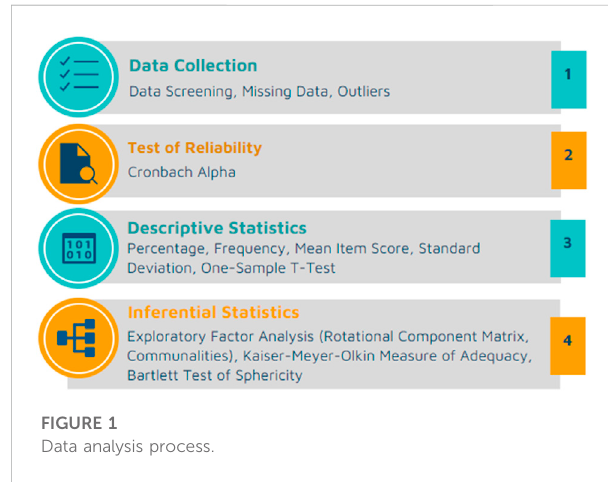
FIGURE 1 Data analysis